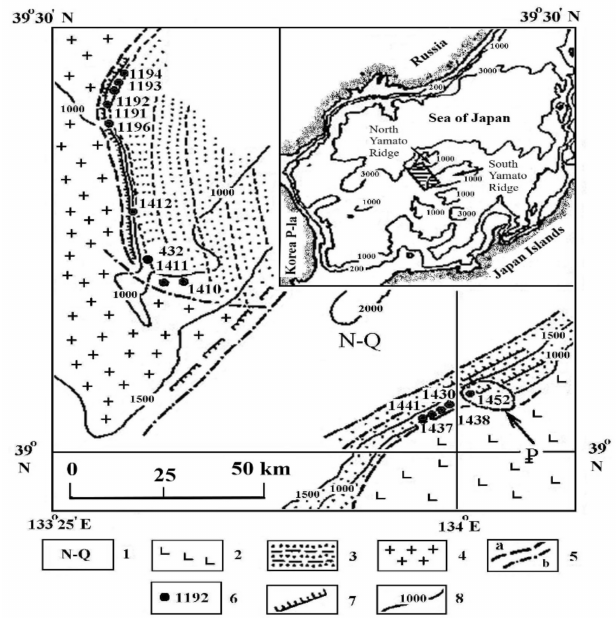
Figure 2. Geological chart of the Yamato Upland (Sea of Japan) [12,13]. Location of corrensite-bearing rocks. 1—marine Neogene-Quaternary deposits; 2—Cenozoic volcanic rocks (basalts, andesites and their tuffs); 3—Early Cretaceous rocks; 4—Late Paleozoic rocks (granits, diorites and gneisses); ) Paleocene